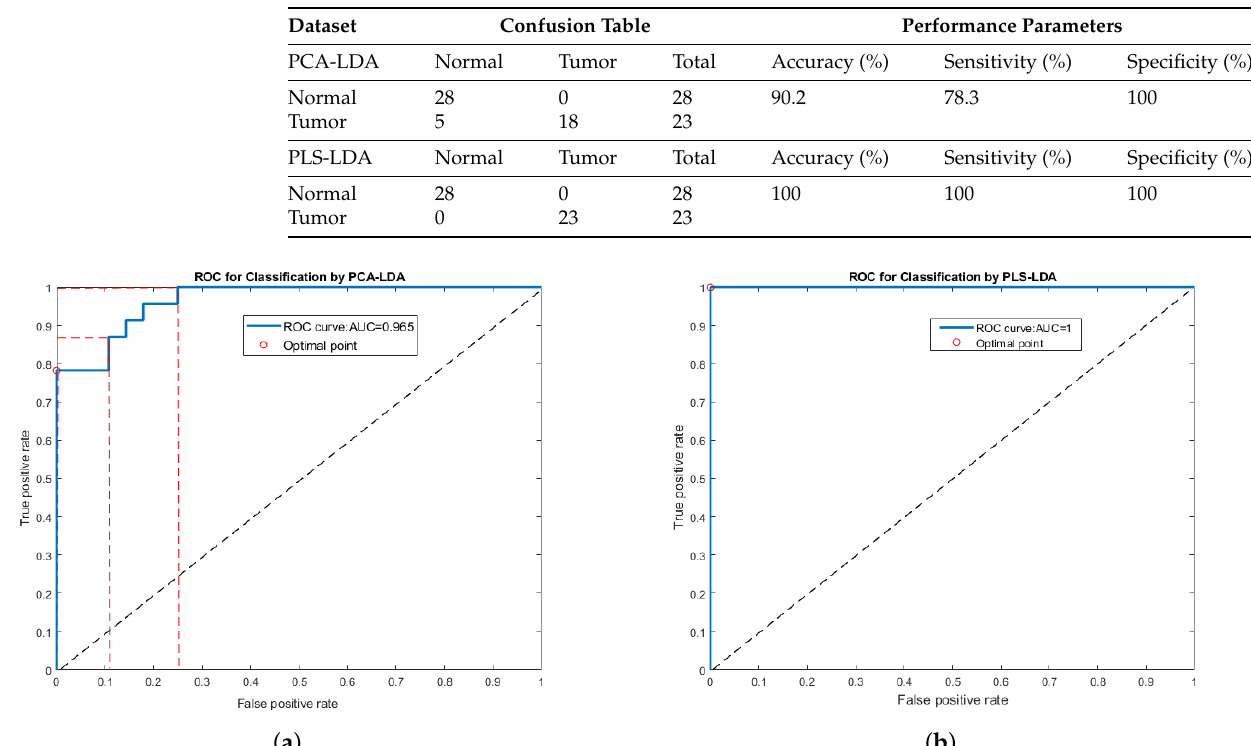
Figure 5. ROC curves of the two-group study for all cut-off values using ( a ) PCA-LDA and ( b ) PLS-LDA classifier